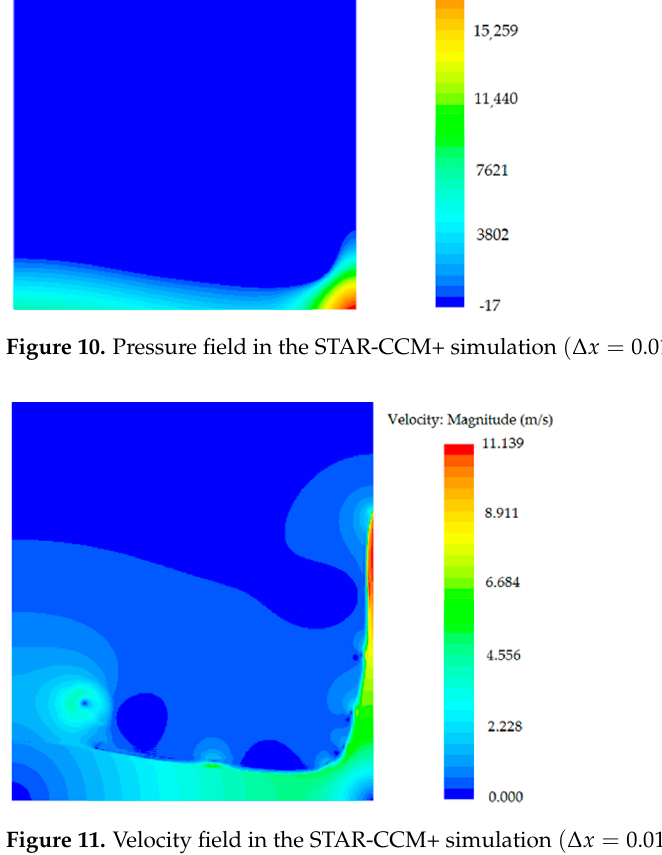
( . Figure 11. Velocity field in the STAR-CCM+ simulation ( ∆ x = 0.0125 m, t = 0.9 s ) . Figure 11. Velocity field in the STAR-CCM+ simulation Figure 11. Velocity field in the STAR-CCM+ simulation ( .